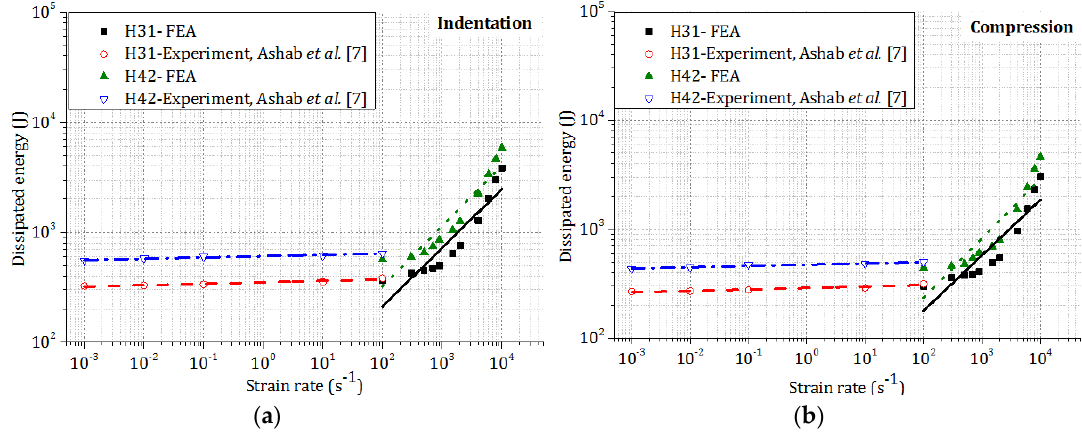
Figure 10. Effect of high strain rate on the total dissipated energy of two types of honeycombs: ( a ) indentation; ( b ) compression.